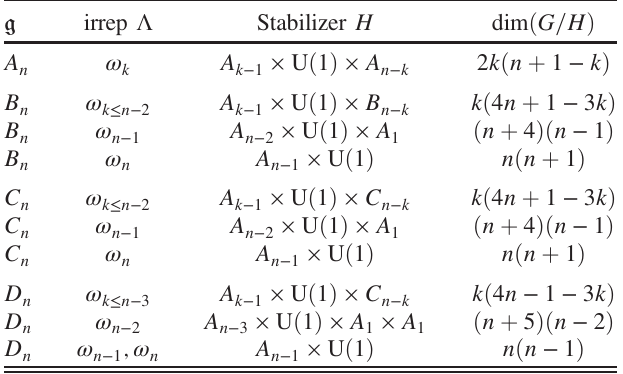
TABLE II. Symmetry-breaking patterns for all the fundamental for the family of classical Lie algebras g . representations Λ ¼ ω k